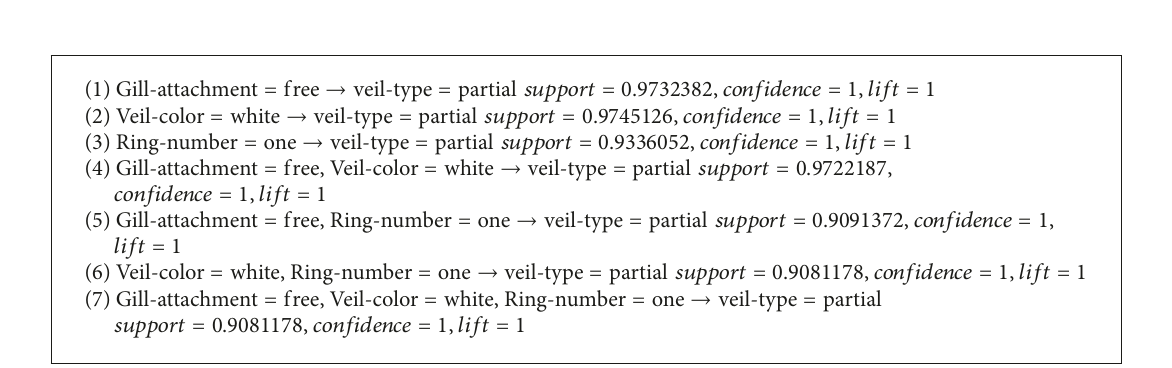
Algorithm 2: A subset of the mining result of mushroom dataset.